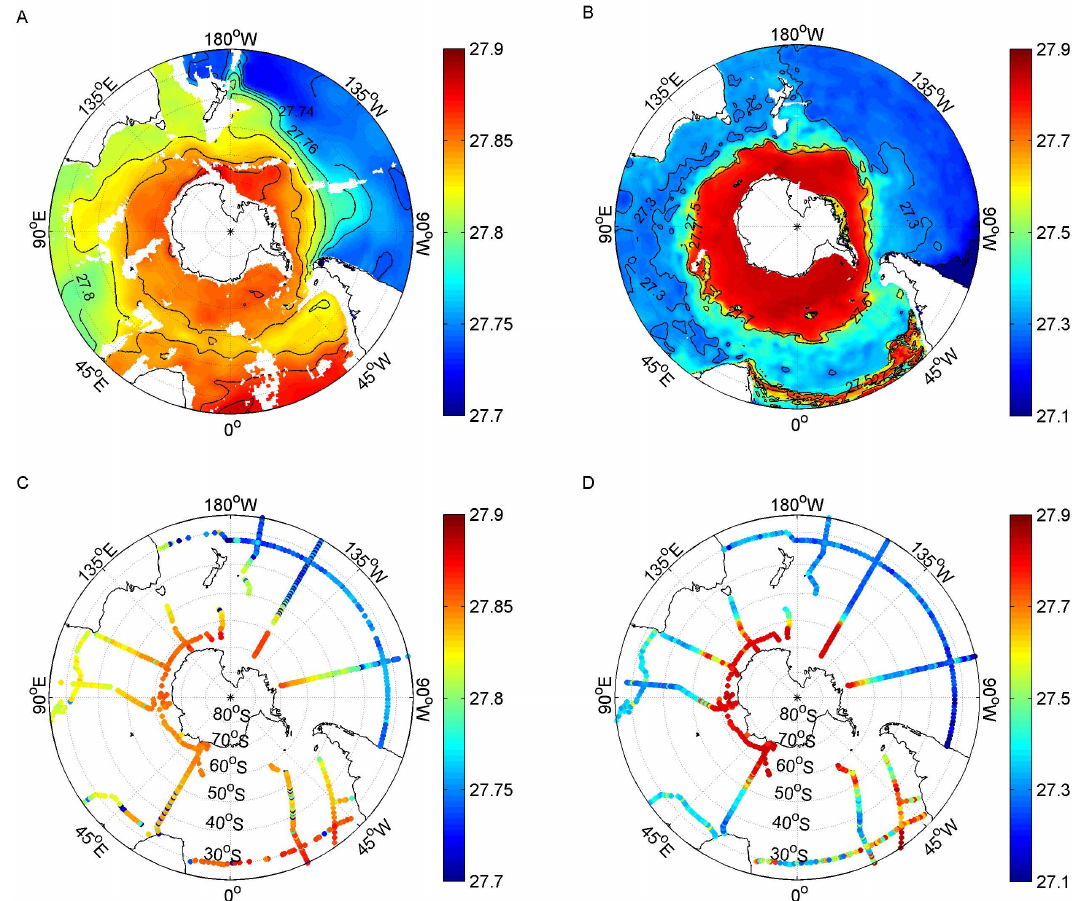
Fig. 7. Potential density of the (A) CSH (contours at σ θ = 0 . 02 intervals) and (B) ASH (contours at σ θ = 0 . 2 intervals) predicted from the CARS 2009 data (January). Potential density of (C) CSH and (D) ASH from the bottle data from GLODAP and